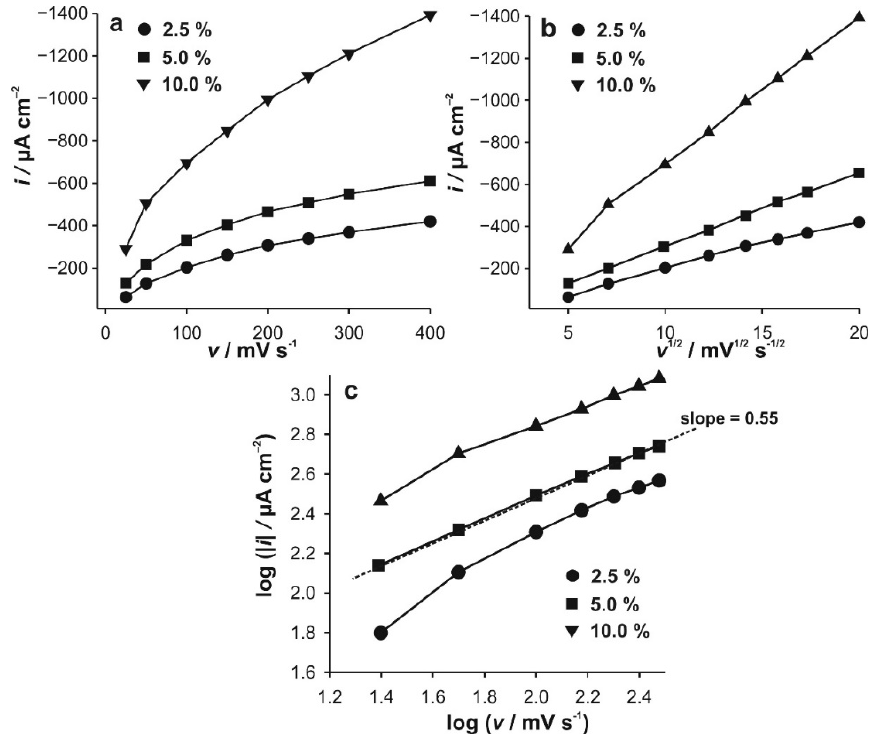
Figure 3. Dependences of the cathodic peak currents for the CPEs modified with different amounts of materials on: ( a ) scan rate; ( b ) square root of scan rate; ( c ) logarithm of oxidative current peak vs logarithm of scan rate. The dependences were obtained from the cyclic voltammograms presented in Figure 2.